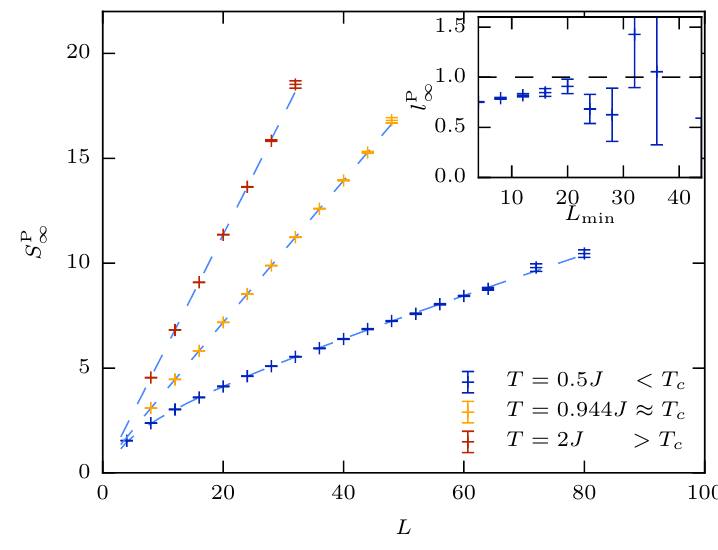
Figure 3: Participation entropy S P of the line shaped subsystem in a three dimensional an- ∞ tiferromagnet (panel (b) of Fig. 1) at different temperatures. Below the critical tempera- ture T , the thermodynamic limit ordering with a breaking of the continuous SU ( 2 ) symme- c try shows up on finite systems as the participation entropy acquires a logarithmic correction term. The inset shows the prefactor of this logarithmic term obtained from fits to the form = a + l + b = S P ∞ L ∞ ln L ∞ , which agrees well with l ∞ ∞